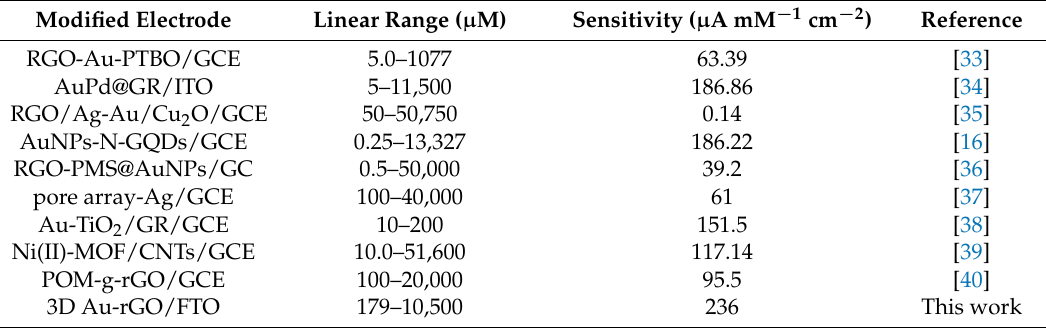
Table 2. Comparison of different modified electrodes for H 2 O 2 determination.